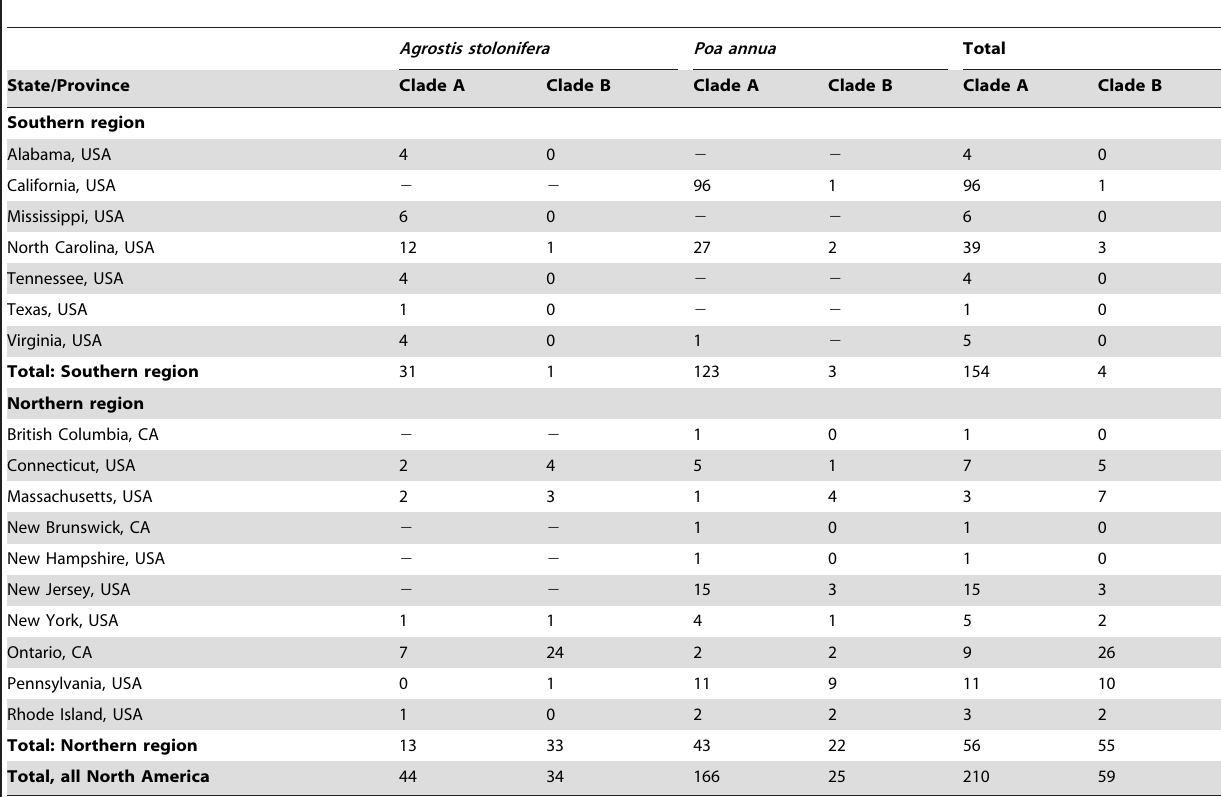
Table 4. Summary of the diagnosis of Colletotrichum cereale subgroups by geographic locale using the Apn2 real-time detection assays, A-Apn2 and B-Apn2.